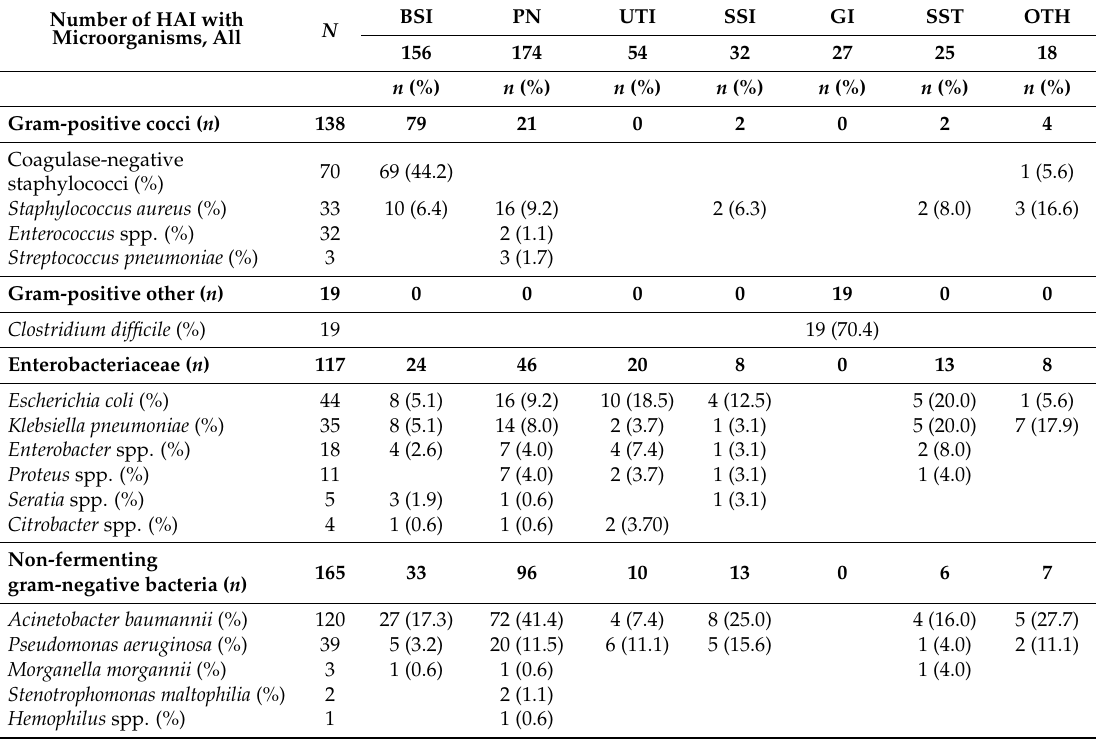
Table 3. Microorganisms isolated in HAI in the ICU,